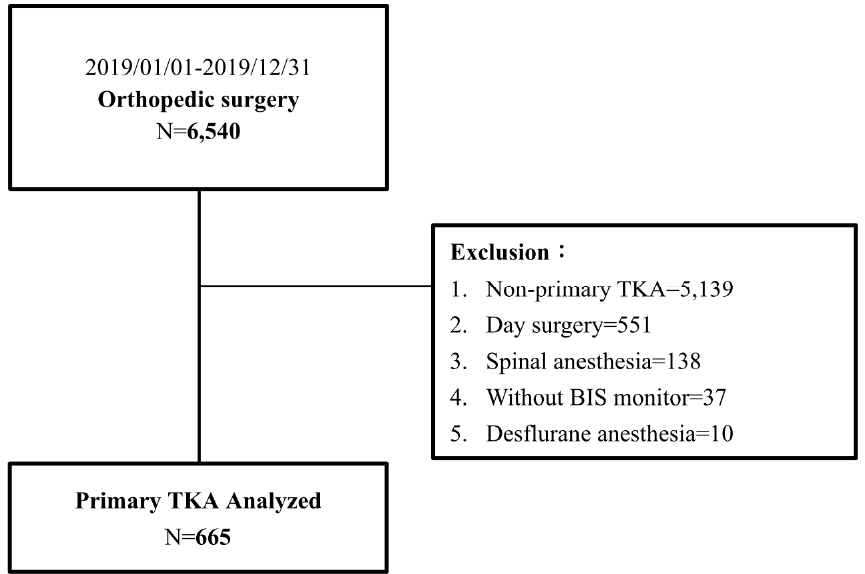
Figure 1. Flow diagram of POV study in patients with primary TKA.